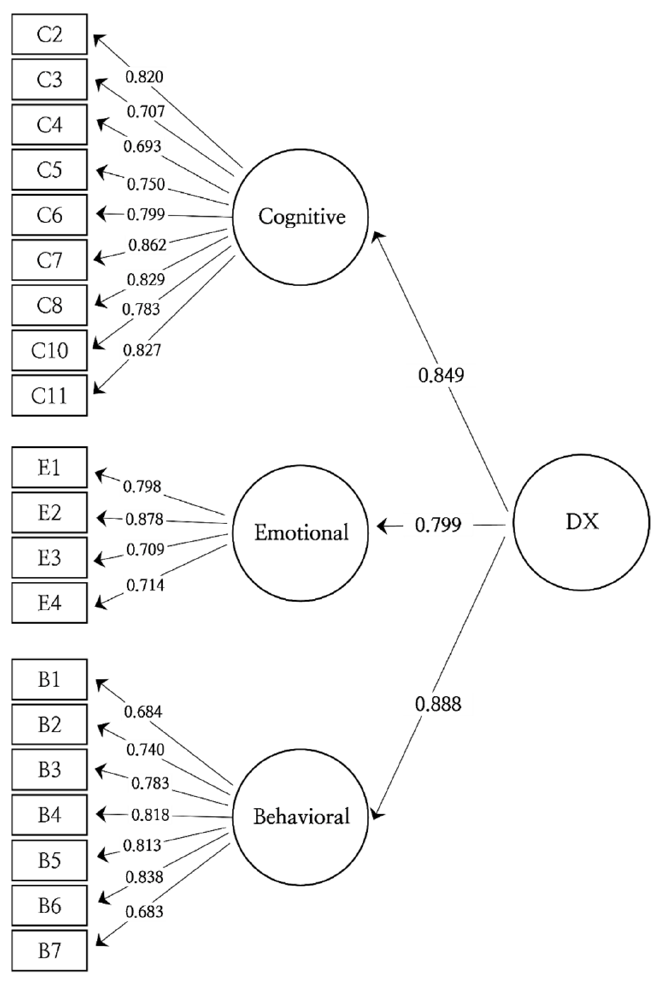
Figure 3. The results of the test of nomological